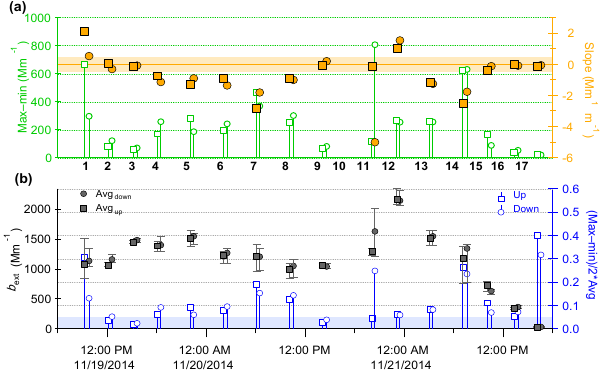
Figure 2. Time series of (a) vertical difference (max – min) and slope of extinction versus height and (b) extinction and vertical dif- ference ((max–min) /( 2 × avg)) for each vertical profile during the haze episode in November. The circles refer to the down profiles while boxes indicate the up profiles.